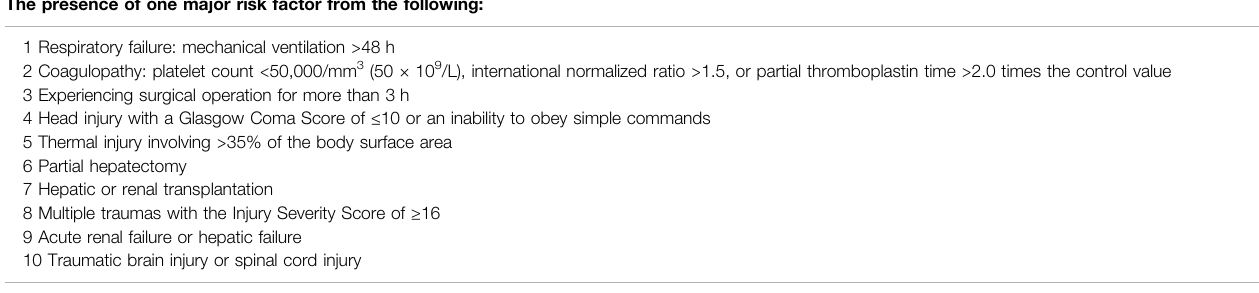
TABLE 1 | Risk factors for stress ulcer (Cook et al., 1994; ASHP Therapeutic Guidelines on Stress Ulcer Prophylaxis, 1999; Bez et al., 2013; Bo et al., 2018; National Health Commission of the People ’ s Republic of China, 2020). The presence of one major risk factor from the